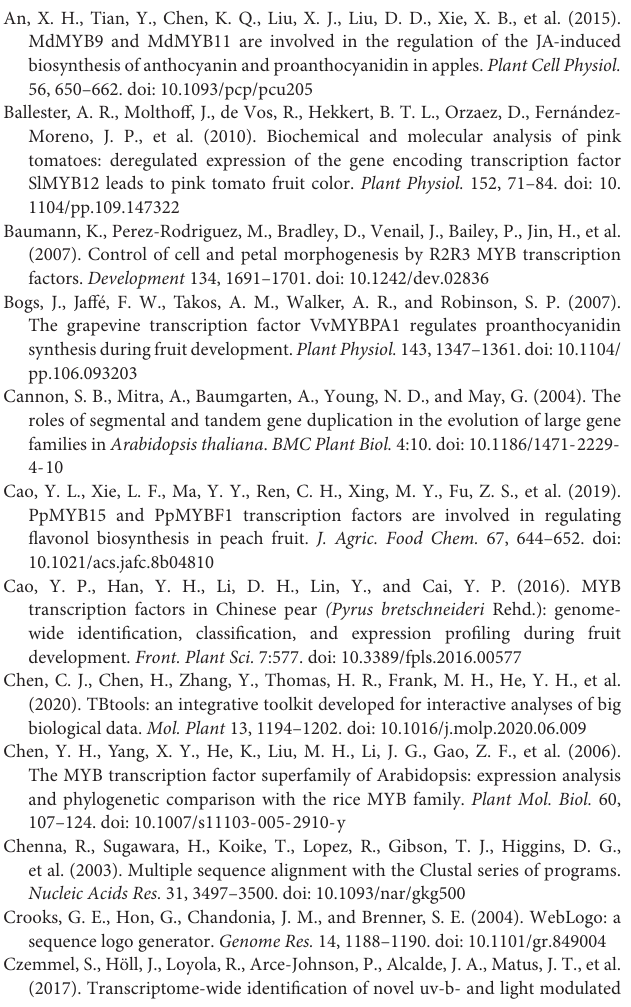
Supplementary Figure 4 | Schematic representations for the interchromosomal relationships of MrMYB genes. (A) Gray lines in the background mean collinear blocks within Chinese bayberry, red lines indicate syntenic MYB gene pairs. (B) Duplicated gene pairs of MrMYB genes are sorted according to their assigned MYB classes. Supplementary Figure 5 | Syntenic analysis of MYB genes between Chinese bayberry and Juglans regia (A) , Pyrus bretschneideri (B) , Prunus persica (C) , Medicago truncatula (D) , or Arabidopsis thaliana (E) . Gray lines in the background mean collinear blocks between Chinese bayberry and other plant genomes, and red lines indicate syntenic MYB gene pairs. Supplementary Figure 6 | Phylogenetic analysis of all MrMYBs and functional flavonoid-related MYB proteins from other plants. The clades are shown in different colors. Supplementary Table 1 | Primers for MrMYB gene amplification and T-easy vector constructions. Supplementary Table 2 | Primers for promoter amplification and pGreenII0029 62_SK vector constructions. Sequences of restriction sites are underlined. Supplementary Table 3 | Primers for promoter amplification and pGreen II0800_LUC vector constructions. Sequences of restriction sites are underlined.